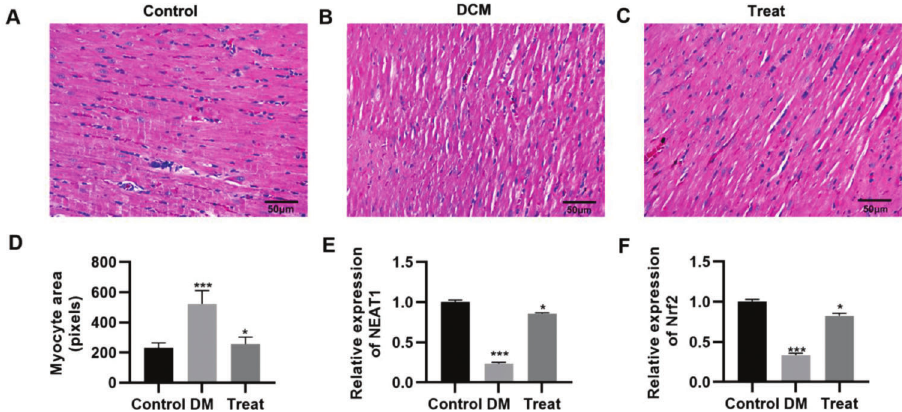
Figure 6 - Treatment with the combination of dendrobium mixture and metformin improved the morphology of heart tissues in rats with streptozotocin-induced diabetes mellitus. A-C, Hematoxylin and eosin staining of the heart tissue of the rats in each group; D, Treatment with dendrobium mixture and metformin improved myocardial cell size in streptozotocin-induced diabetic rats; and E-F, upregulated the expression of NEAT1 and Nrf2 . * p o 0.05, *** p o 0.001, Kruskal-Wallis test followed by Dunn ’ s multiple comparisons test. DCM, diabetic